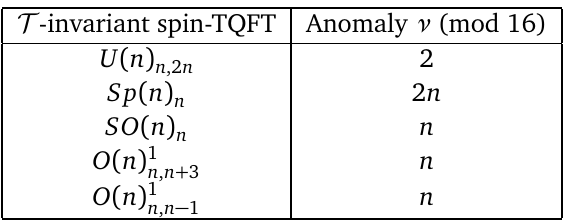
Table 1: Time-reversal invariant spin TQFTs and their associated anomaly ν . These anomalies have been computed by various methods [ 8, 16–20 ] . The notation for the levels in the O ( n ) Chern-Simons theory is explained in [ 15 ] . The anomaly for the O ( n ) 1 theories is determined based on the consistency of the conjectured phase diagrams of [ 15, 20 ] . Note that in general redefining the orientation of spacetime changes ν → − ν [ 1 ] . For a given theory the sign is convention dependent, but the relative sign between theories is meaningful. For instance, in the U ( n ) sequence n ,2 n it is natural to fix the sign to be ( − 1 ) n − 1 [ 20 ] . Some of the TQFTs above also admit unitary global symmetries of order two and these can be combined with T to produce other antiunitary symmetries of the model with a different value of ν . An example that will occur below is the T-Pfaffian theory vs. the CT-Pfaffian theory [ 3–5 ] . In addition, the value of ν can depend on other choices like the eigenvalue of T 2